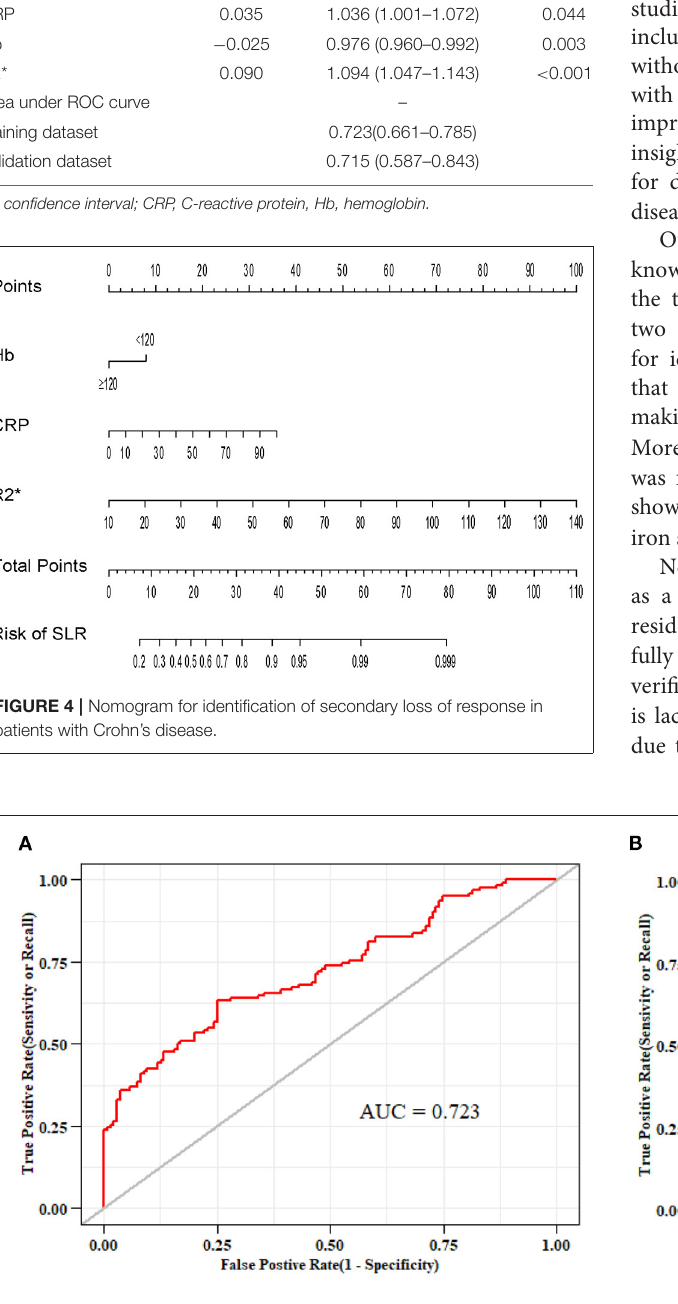
FIGURE 5 | Receiver-operating characteristic curves for nomograms used to identify secondary loss of response to infliximab (A) in the training cohort (area under the curve, 0.723) and (B) validation cohort (area under the curve, 0.715).